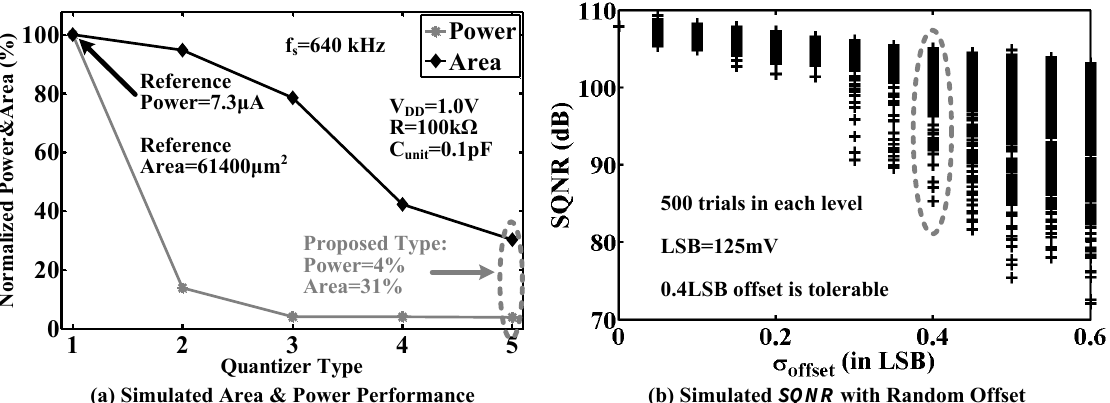
Figure 12. ( a ) Simulated area and power performance of the introduced five nine-level quantizers; ( b ) Simulated signal-to-quantization noise ratio ( SQNR ) with random comparator offset, where there are 500 trials at each